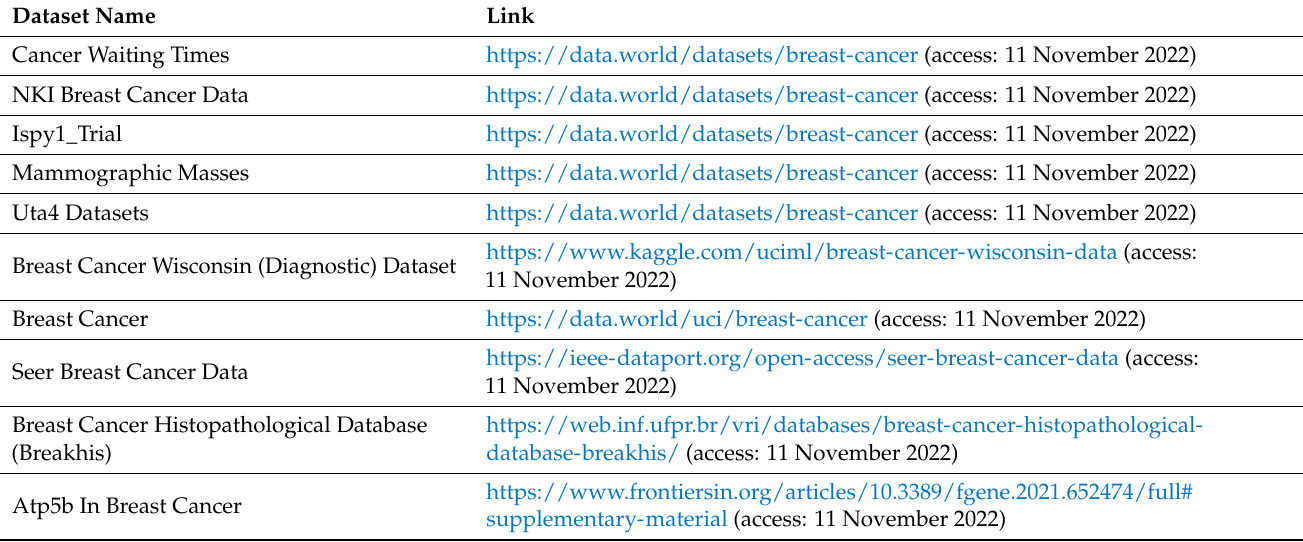
Table 1. Breast Cancer datasets and their links.